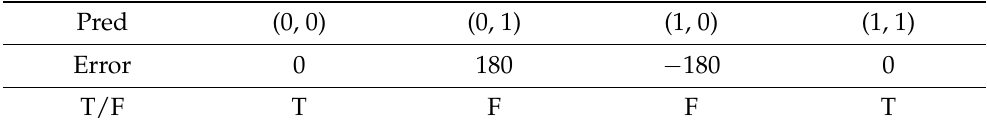
Table 3. Relative angle